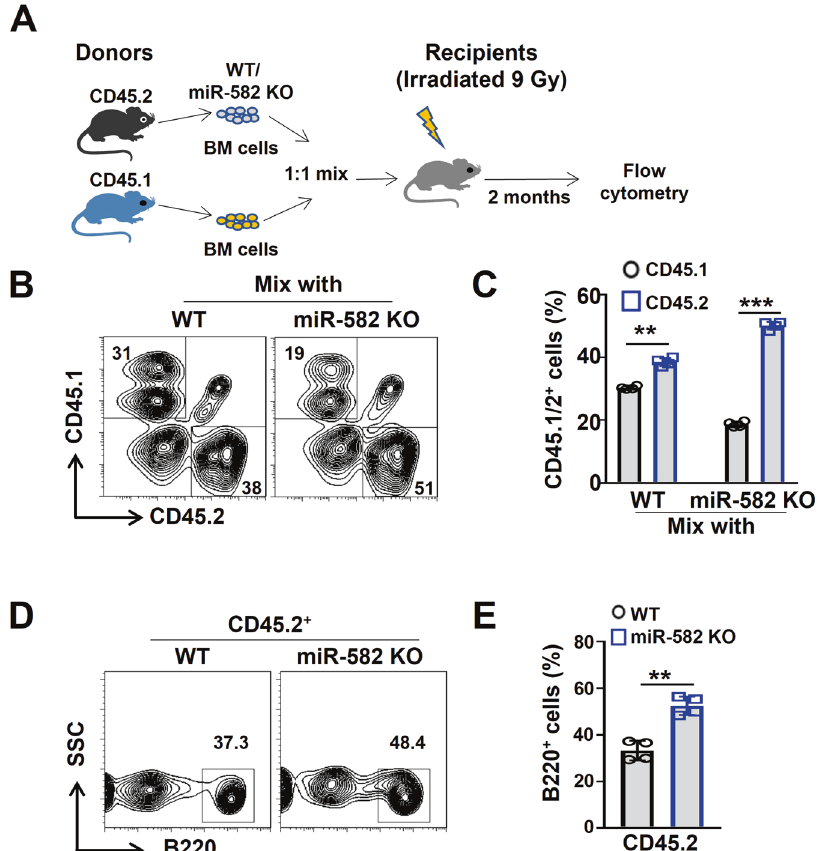
recipient mice were analyzed for B220 + B cells in the CD45.2 + populations by fl ow cytometry and quantitatively compared ( n = 4). Bars represent means ± SEM, ** P < 0.01, *** P <